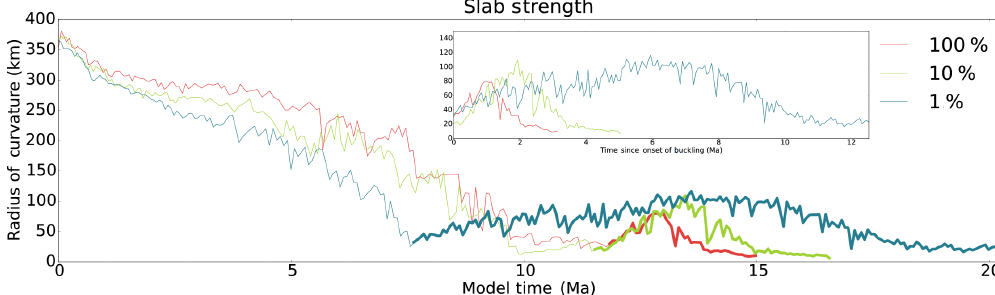
Figure 7. The change in radius of curvature for three models with the same plate strength and three different weakening parameters, models 15, 14, and 13. Bold lines show the period of slab buckling. The inset shows the radius of curvature with the plot shifted to the onset of buckling.